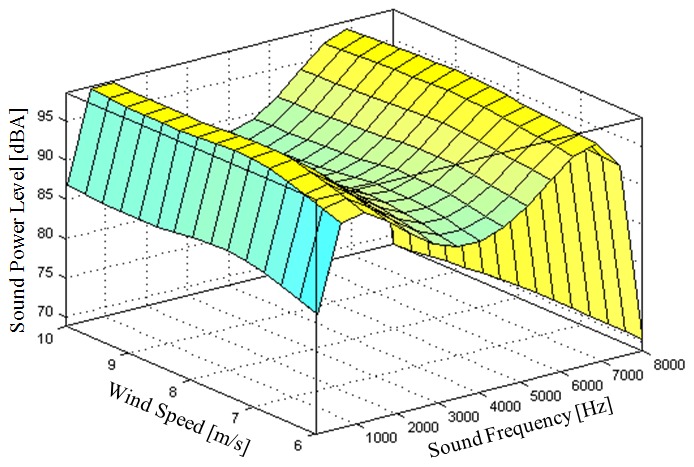
ANFIS predicted relationship between wind speed, sound frequency and sound power level of the wind turbines.